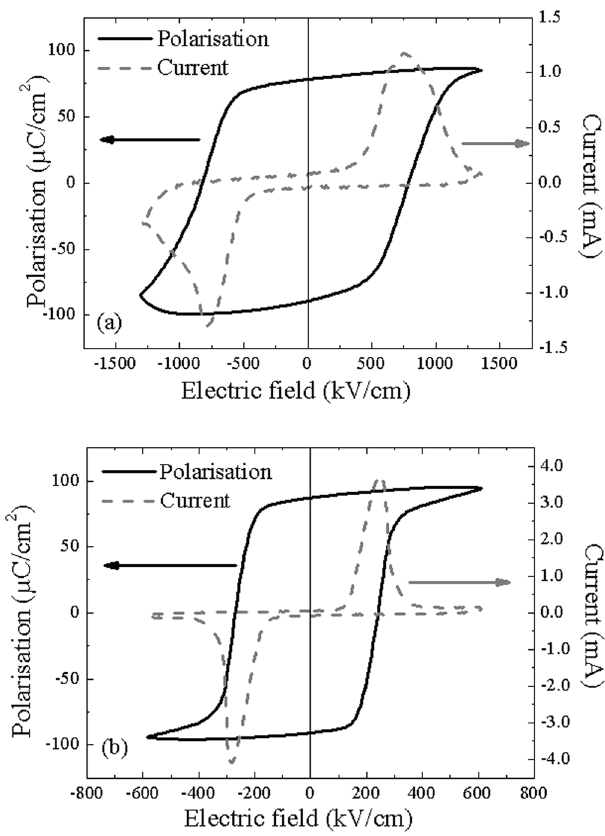
Figure 2. Ferroelectric polarizations and switching current hysteresis loops of ( a ) c -domain and ( b ) a / c -domain